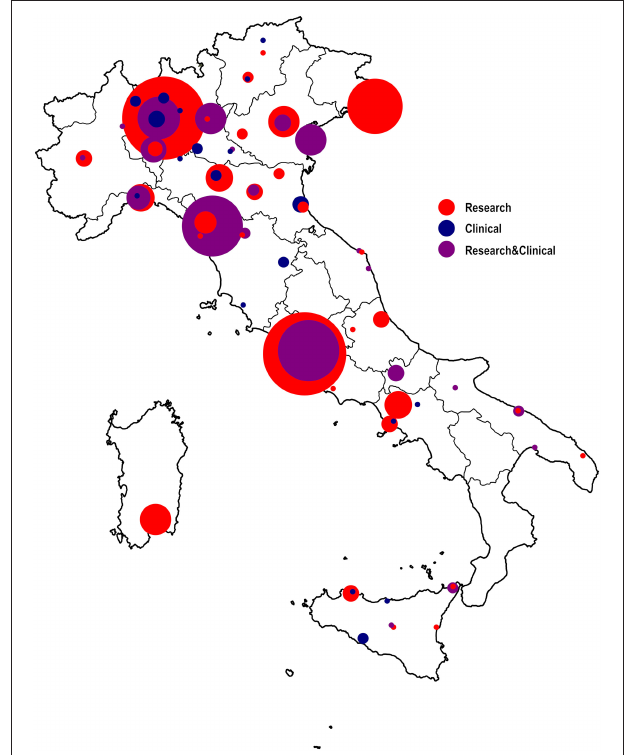
FIGURE 1 | Mapping of Italian neuroscientific, neurophysiological, and neuropsychological research facilities. Laboratories and units have been clustered according to their main working activities: in red the laboratories that carry out research activities only, in blue the centers that primarily conduct clinical activities, in violet the centers that deal with both research and clinical activities. The width of the circles mirrors the number of laboratories/units in the reference geographical territory, for each clustered primary working activity (i.e., research, clinical,